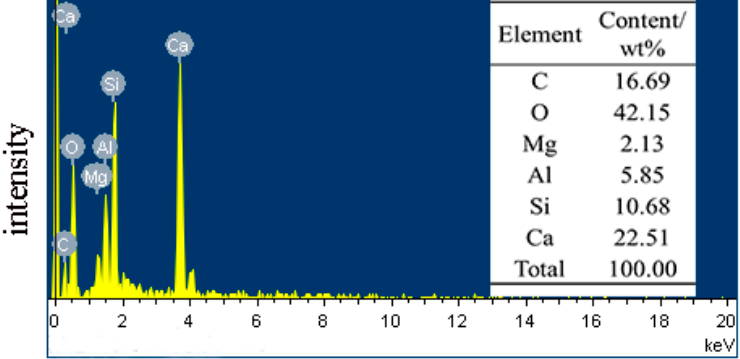
Figure 14. EDS analysis of white particles in the slag (Point 1 in Figure 13c).